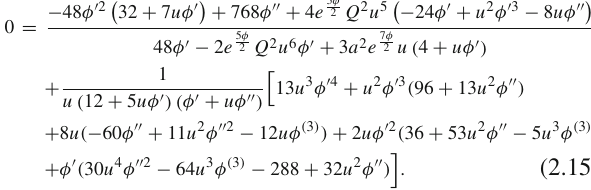
Fig. 1 The typical falling string profiles moving in the x − z plane in the anisotropic background, with the angle φ = 0 (blue), φ = π/ 3 (orange), and φ = π/ 2 (green) where φ is measured with respect to the z-axis. Each line shows the string at different instant time. The strings are created at a point at u c = 0 . 1 u h and evolve to the extended objects by time evolution. The value of the anisotropy parameter is a = 4 . 4. The quark, corresponding to the half of the string, has 100 GeV energy and the temperature of the plasma is 350